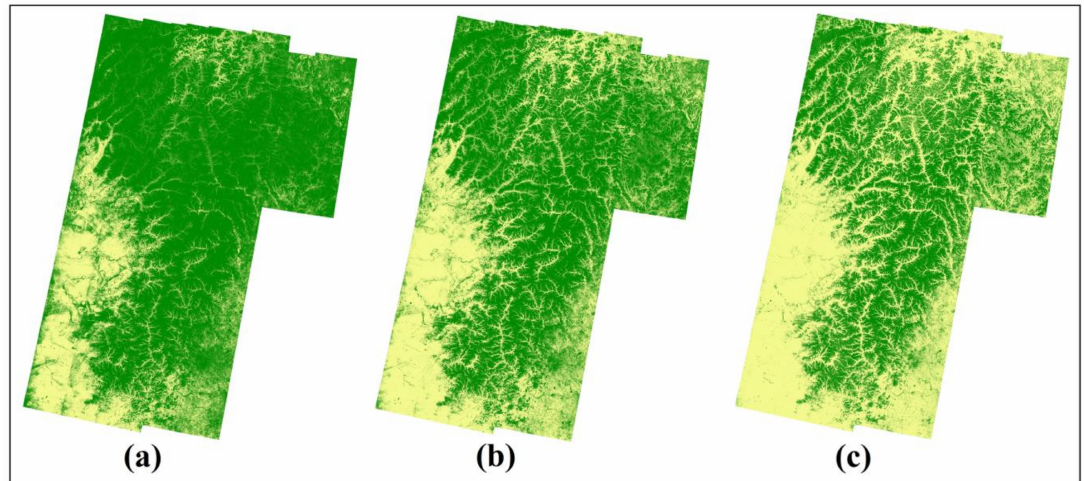
Figure 13. Forest maps produced by di ff erent thresholds of canopy coverage estimated by the model_2018: ( a ) > 10%; ( b ) > 20%; ( c ) > 30%. Green: forest, Yellow: non-forest.